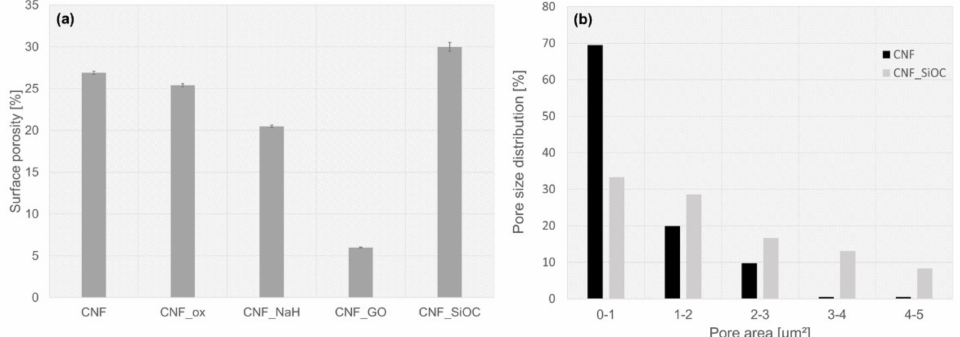
Figure 4. Surface porosity calculated based on SEM thresholding ( a ); Pore size distribution on the surface of CNF and CNF_SiOC samples ( b ).